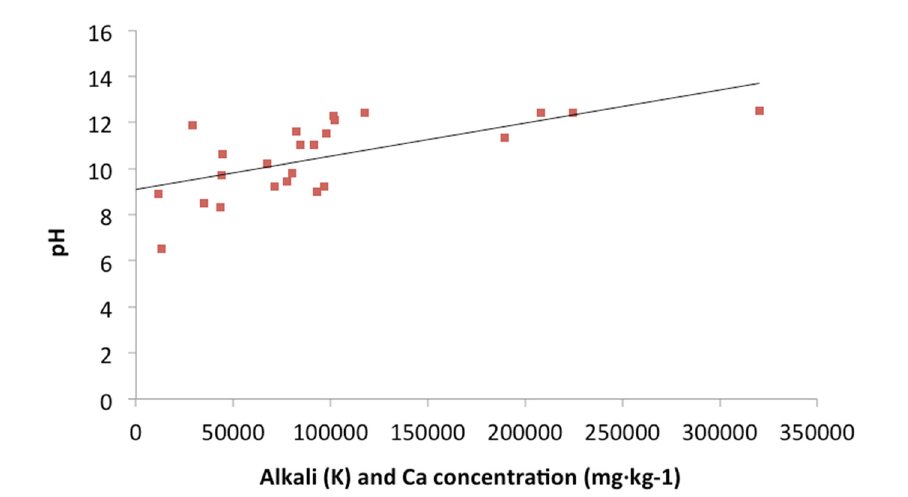
Figure 15. pH values with alkali and Ca concentration for all